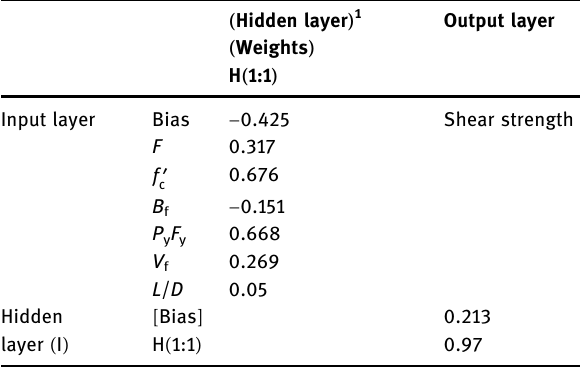
Table 1: Estimated parameters from the present ANN model